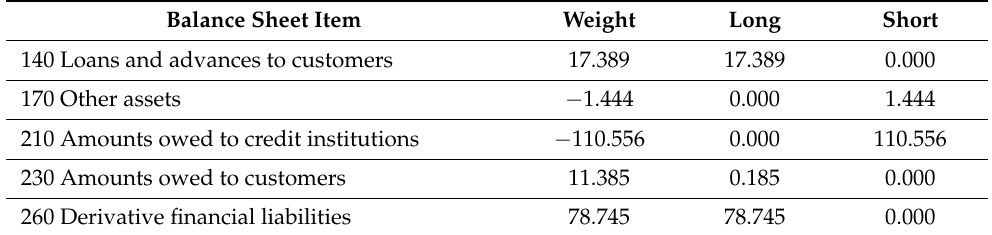
Table 3. Bank assets and liabilities, statistical data, forecast data (Dollar-Neutral Portfolio with Maximum Sharpe Ratio).